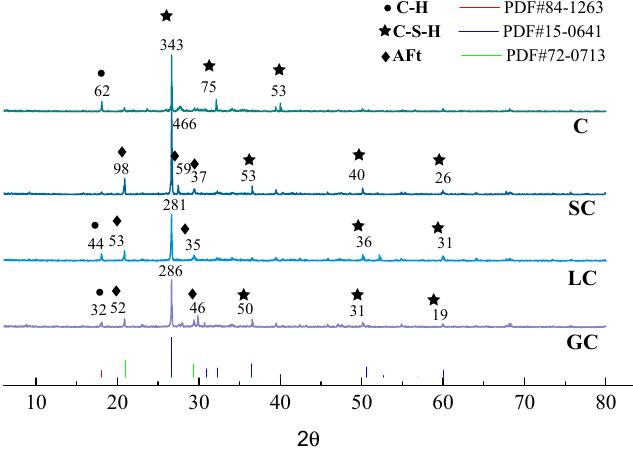
Figure 5. XRD patterns of concrete and ITZ.